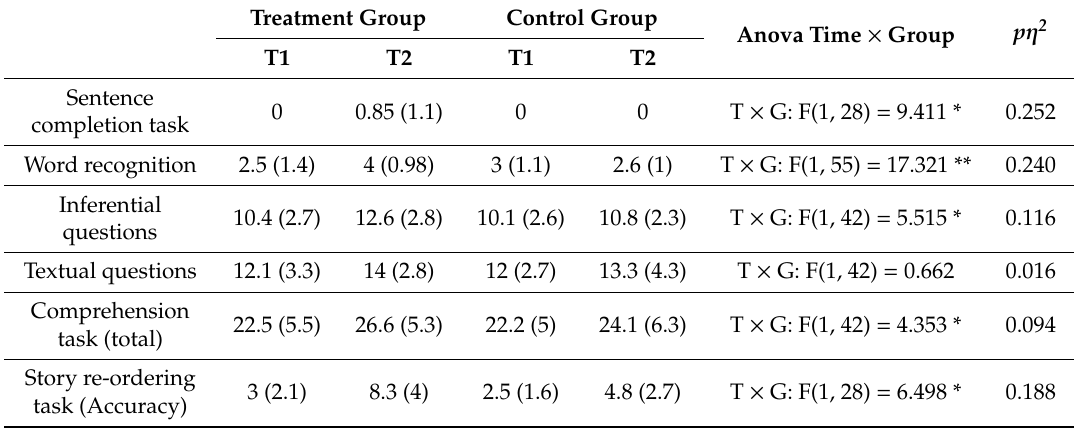
Table 2. Mean (SD) on proximal abilities at Time 1 and Time 2 and group comparisons. Treatment